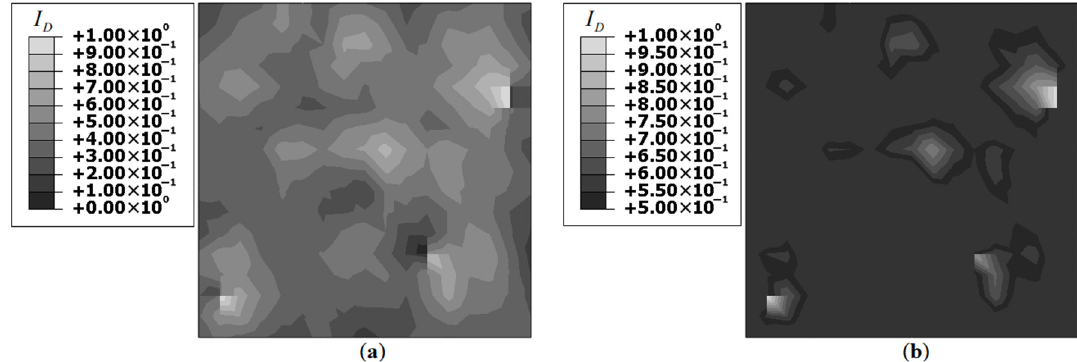
Figure 18. Benchmark iFEM results of 𝐼 (cid:3005) for Damage Case-2 (5% noise) using: ( a ) no threshold, and ( b ) threshold = 0.5.